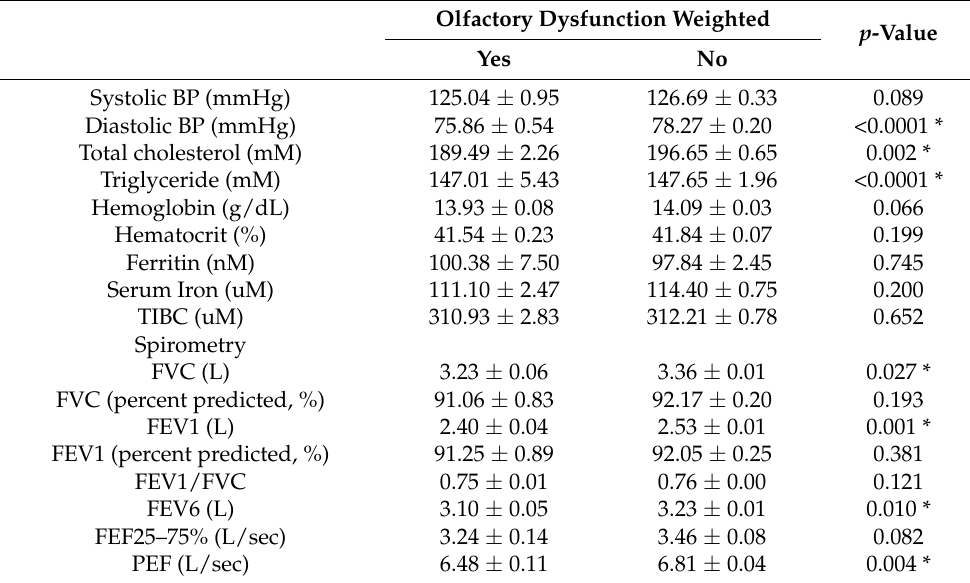
Table 2. Comparison of the laboratory results according to olfactory dysfunction.